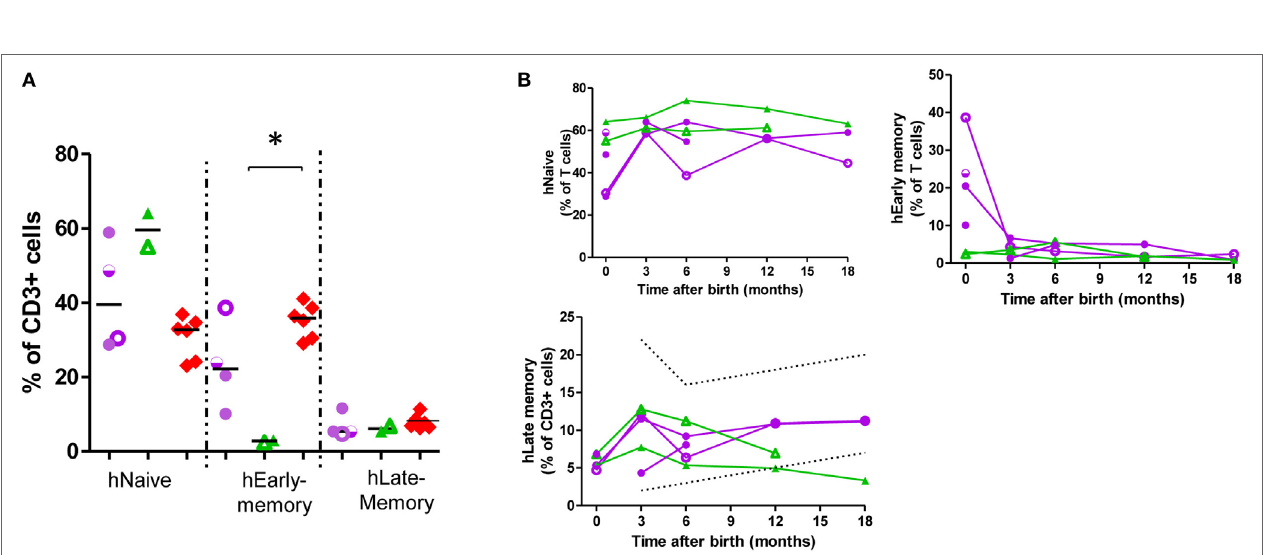
FigUre 2 | Helper CD45RO + CD45RA + T-cells are at a low frequency in exposed infants cord blood. T-cell subpopulation frequency at birth (a) and at follow-up (B) . Dotted lines, described reference ranges; purple circles, adalimumab (ADA)-exposed; green triangles, infliximab (IFX)-exposed; red diamonds, cord blood healthy controls; empty symbols, azathioprine co-exposure; half-empty symbols, prednisone co-exposure. ADA-exposed infants, n = 4; IFX-exposed infants, n = 2.